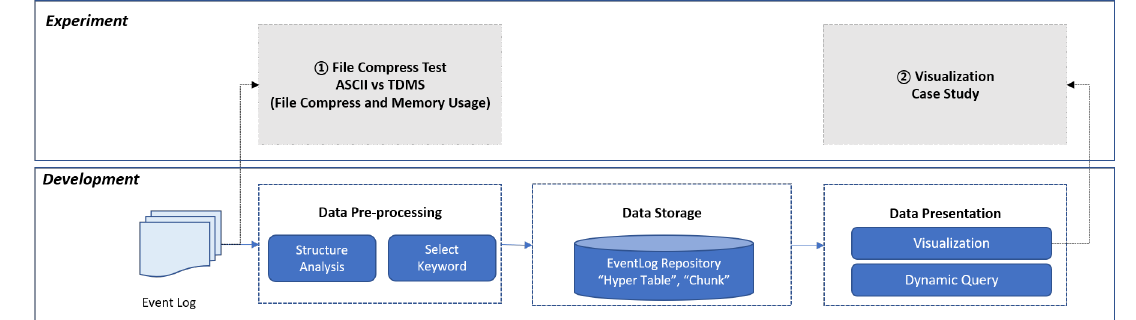
Figure 2. System Architecture.